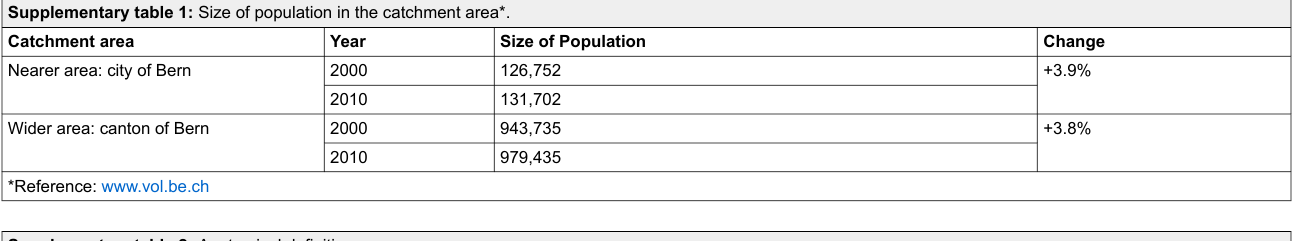
Supplementary table 2: Anatomical definitions. Anatomical